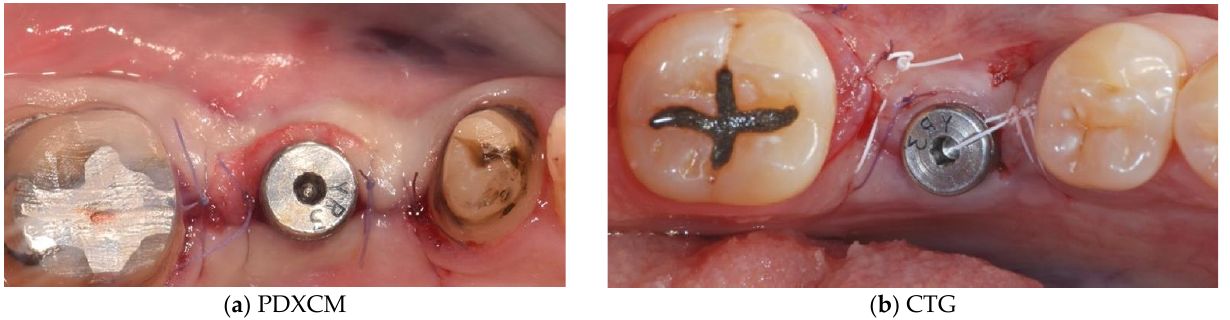
Figure 4. ( a , b ) The PDXCM is sutured to periosteum (right) and CTG is sutured to periosteum (left).